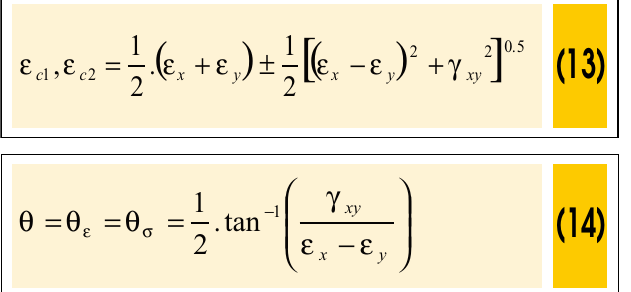
Figure 4 – Free body diagram of the reinforced concrete